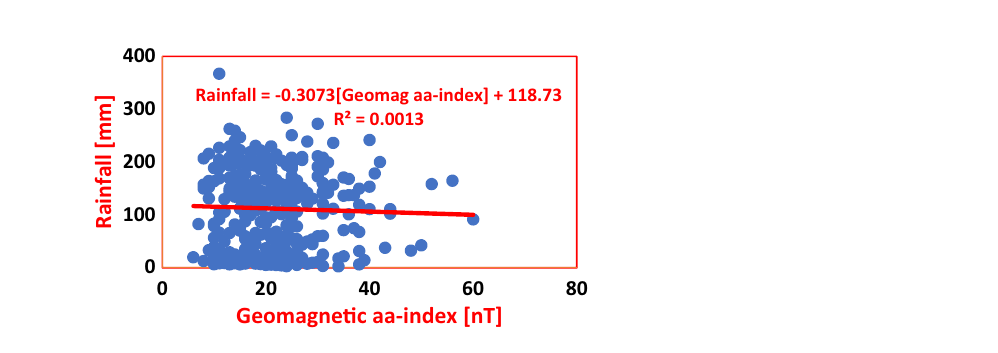
Figure 9. Regression of Geomagnetic aa-index on Rainfall in ABD during Solar Cycles 22–24. From the Regression Equation, a change in Geomagnetic aa-index by 1 nT caused a decrease in Rainfall by 0.3073 mm, with percentage variability of mere 0.13%. These values are too low for classification of Geomagnetic aa-index as a forcing on climate change in the study